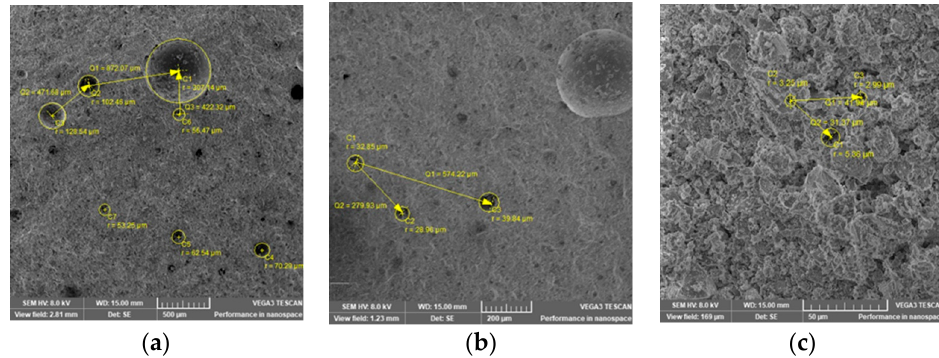
Figure 6. Pores structure of ( a ) and ( b ) CP and ( c ) CP10VSW samples.